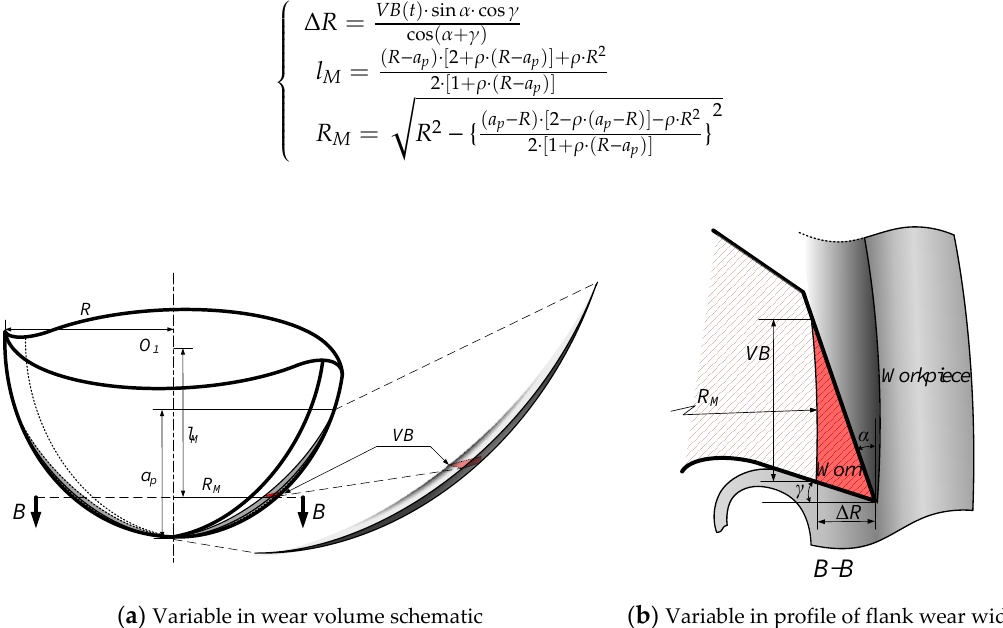
( b ) Variable in profile of flank wear width Figure 6. Variable schematic. Figure 6. Variable